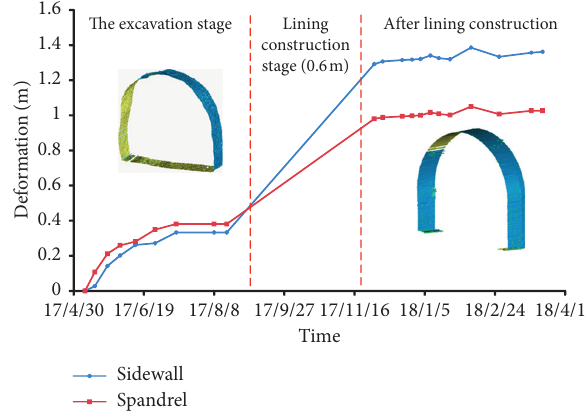
Figure 10: Convergence deformation curve of the tunnel for a typical cross section [10].